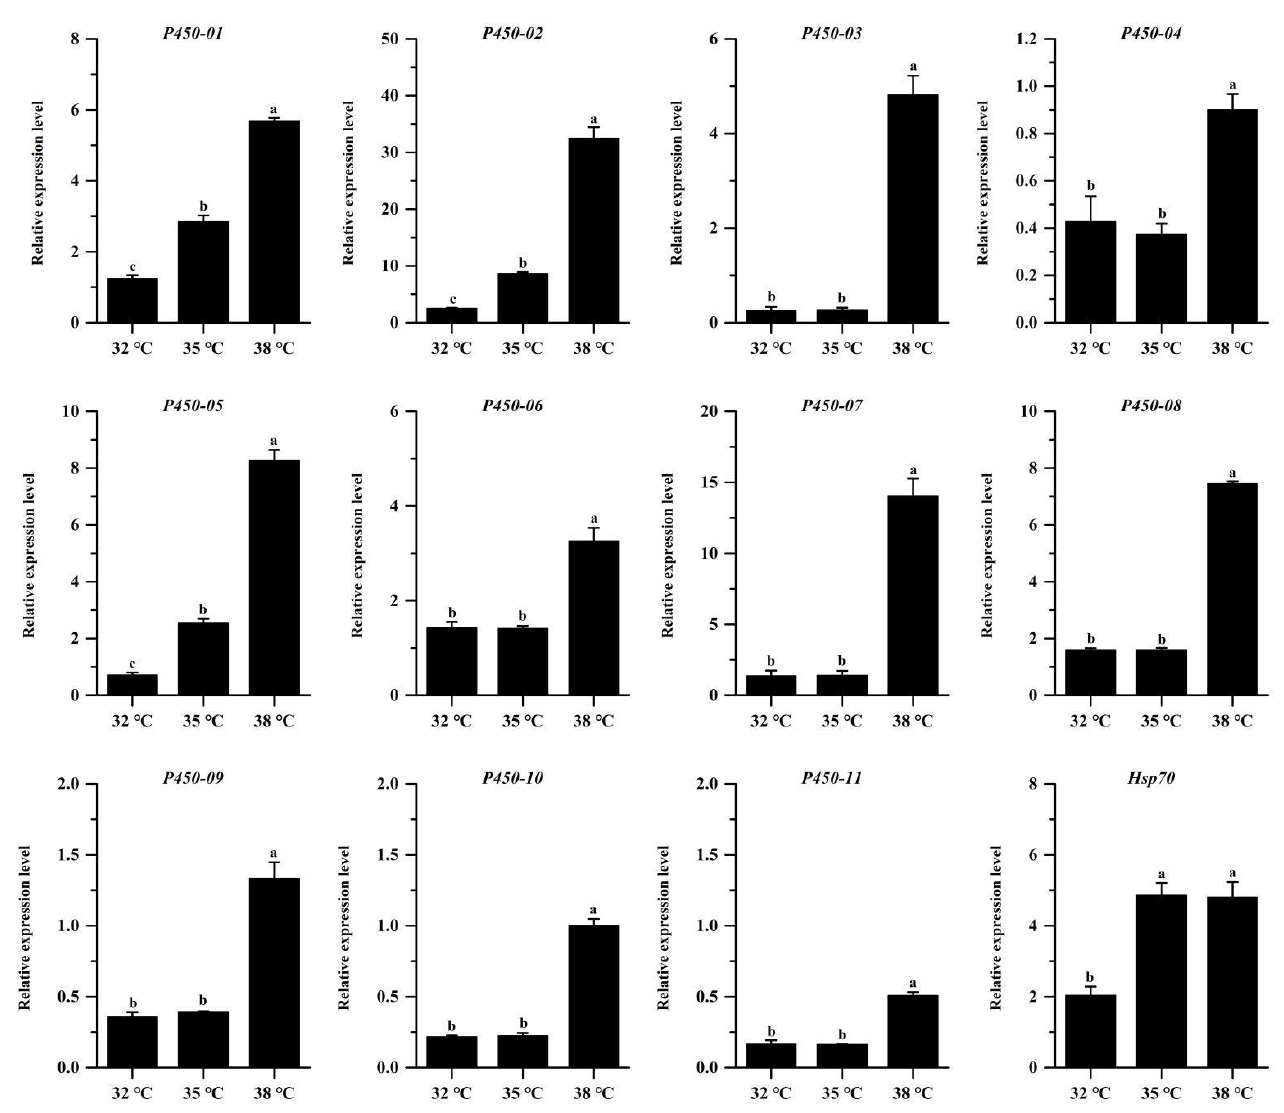
Figure 5. Real-time PCR validation of adult P. quatuordecimpunctata DEGs under different temper- ature stress. For each genes, different letters indicate statistically significant differences (ANOVA; Tukey’s post hoc test; p <